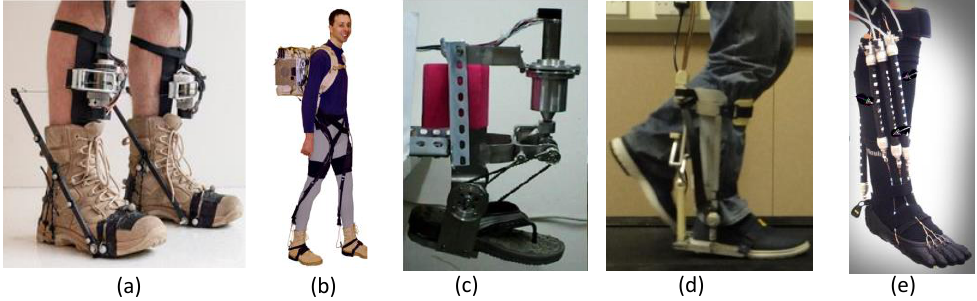
Figure 6. One-DoF ankle exoskeleton using: ( a ) DC motor and struts [27]; ( b ) motor and Bowden cable [28]; ( c ) DC motor and belt [29]; ( d ) two-DoF with active actuators [30]; and ( e ) two-DoF active pneumatic actuators [32].